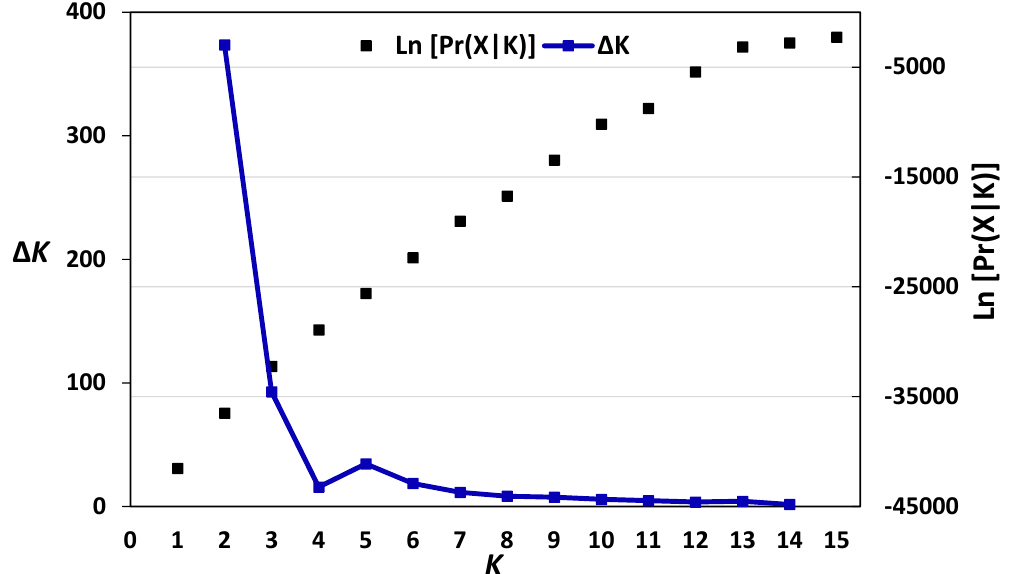
Figure 4. The log-likelihood and Δ K values based on the change rate of log-likelihood function between successive K [41] in the 25 Belgian wheat genotypes.